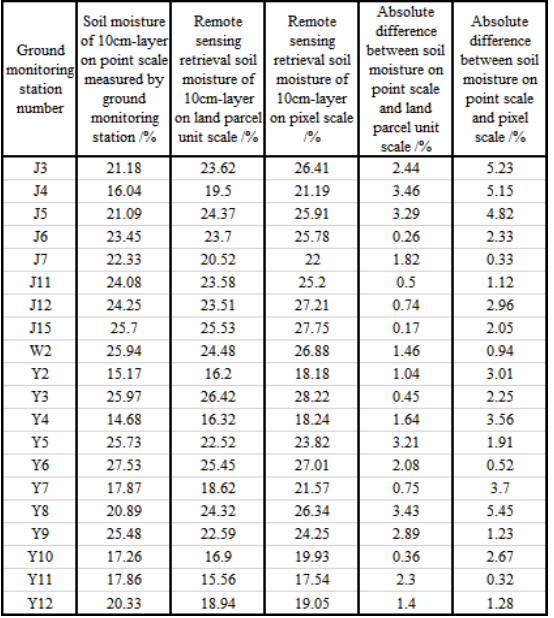
Table 2. Result comparison table of soil moisture of 10cm- layer on point scale measured by ground monitoring station, soil moisture on land parcel unit scale and on pixel scale retrieved by remote